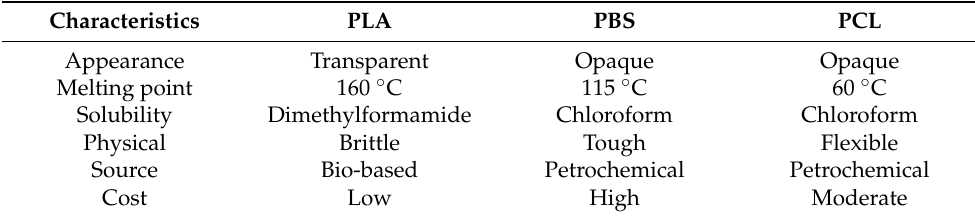
Table 3. Appearance, melting point, solubility, physical, source, and cost of PLA, PBS, and